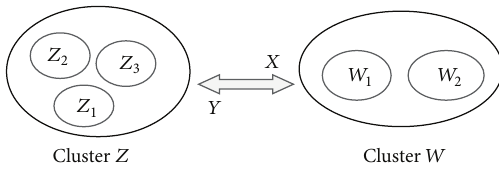
Figure 3: Example of bidirectional relation when 𝑖 ̸=𝑗